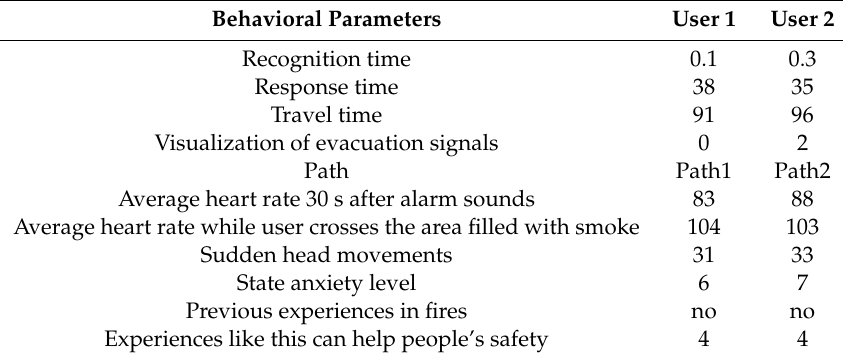
Table 6. Behavioral parameters and state anxiety level after the experience. Behavioral